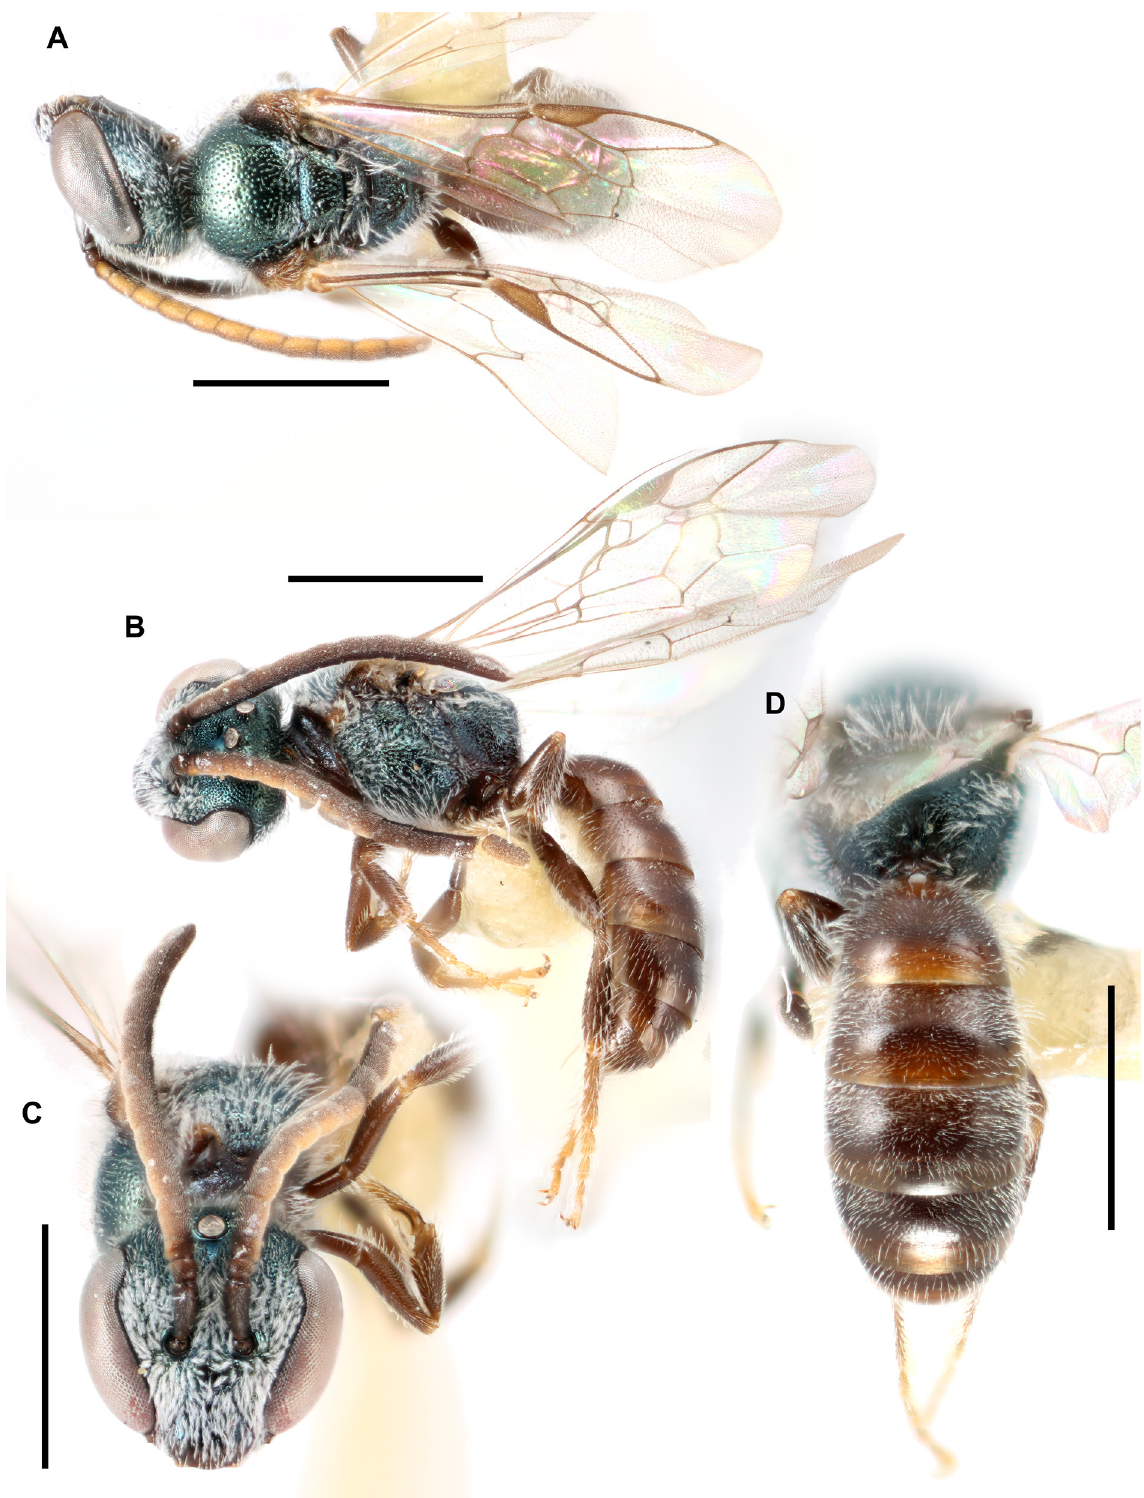
Fig. 65. Lasioglossum ( D .) stictaspis (Sandhouse, 1923), ♂, red-tailed morph. A . Dorsal habitus. B . Lateral habitus. C . Face. D . Metasoma. Scale bars = 1